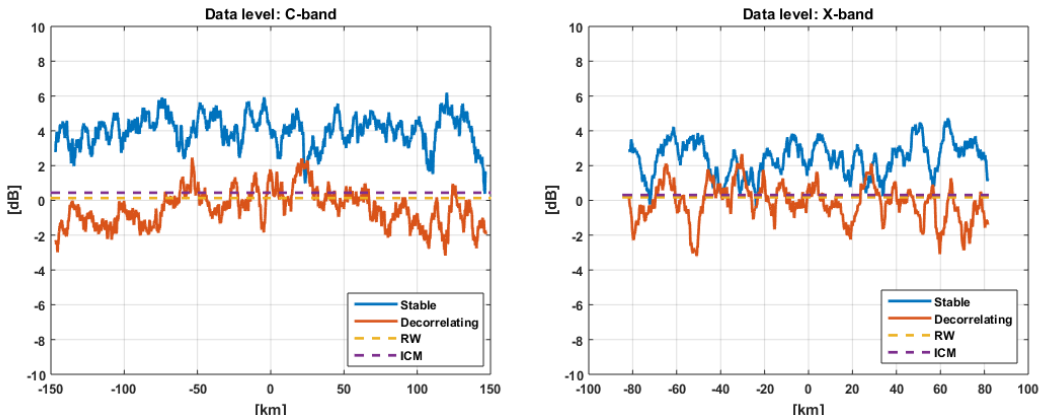
Figure 17. Simulated and predicted data levels for a set of decorrelating targets at C ( left ) and X ( right ) band. The blue line represents the power level of the stable part of the targets. The red line represents the power level of the decorrelating part of the targets. The yellow/purple dashed lines represent respectively the clutter power predicted from the gRW and the ICM model.